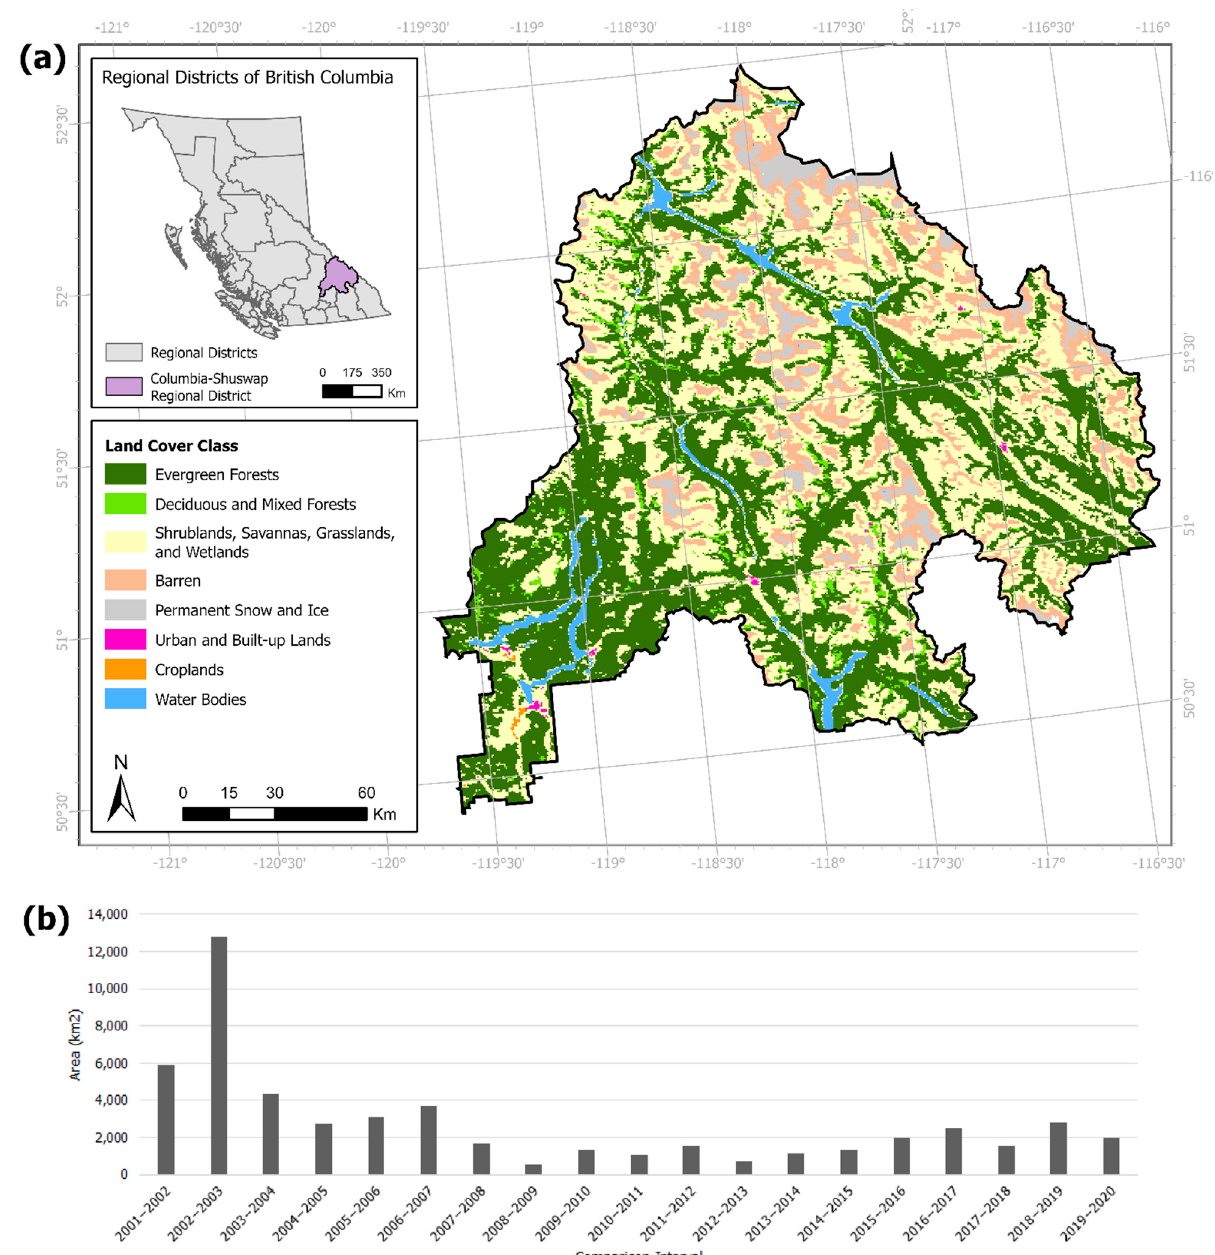
Figure 1. Study area of the Columbia-Shuswap Regional District, British Columba, with ( a ) land cover for 2001 and ( b ) annual net land cover changes for the region from 2001 to 2020. Data are displayed with the NAD 1983 BC Environment Albers projected coordinate system.